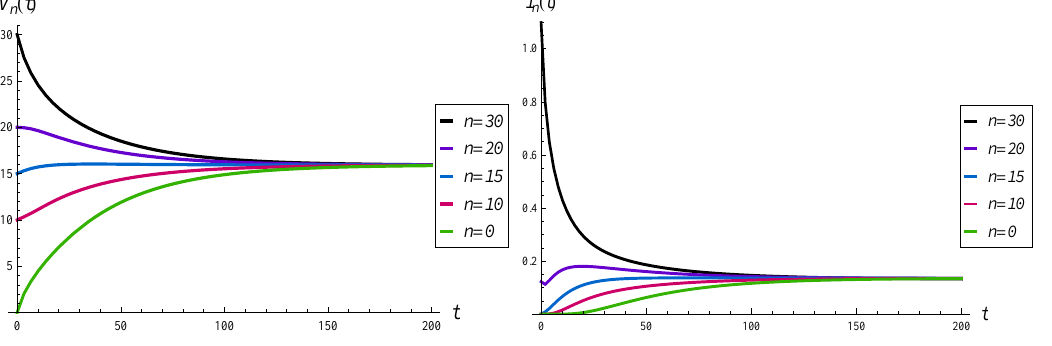
Figure 3. Average waiting time (on the left) and intensity of losses (on the right) vs. time, for different initial buffer occupancies.